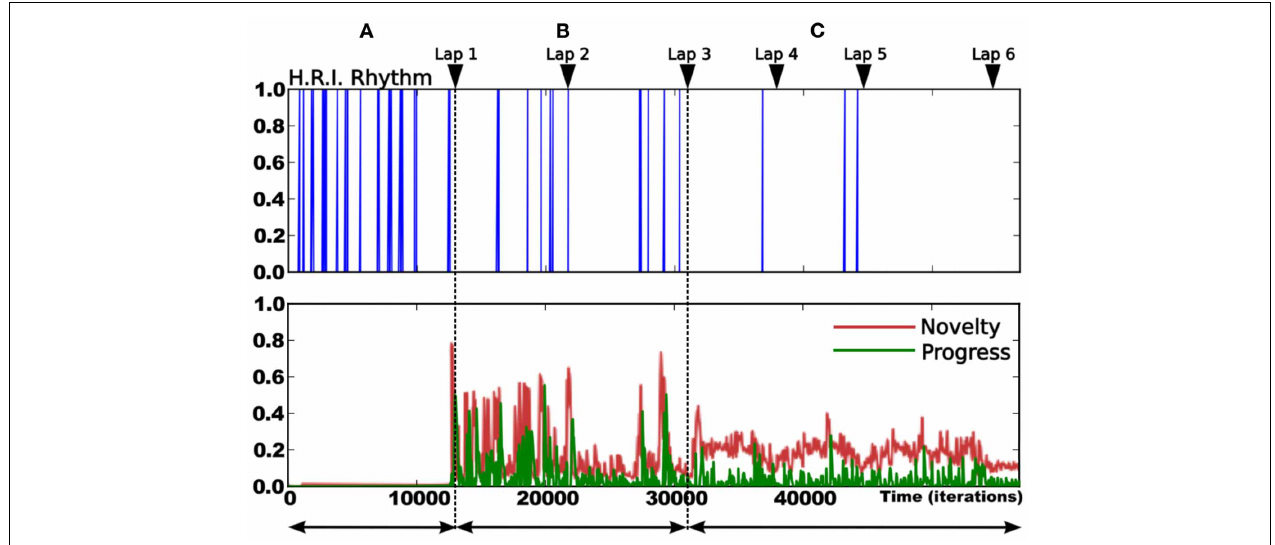
FIGURE 12 | Details of the learning stage over 6 laps. Up: rhythm of human/robot interactions (HRI): Dirac pulses correspond to guiding instants. The frequency of interaction decreases over time. It gives a direct measure of the system’s autonomy (inversely proportional to frequency). Down:novelty (red) and Progress (green) level. We observe 3 different periods: (A) corresponds to the beginning of the learning session (first lap). The high frequency of pulses indicates that the human teacher is roughly directive as the robot does not know